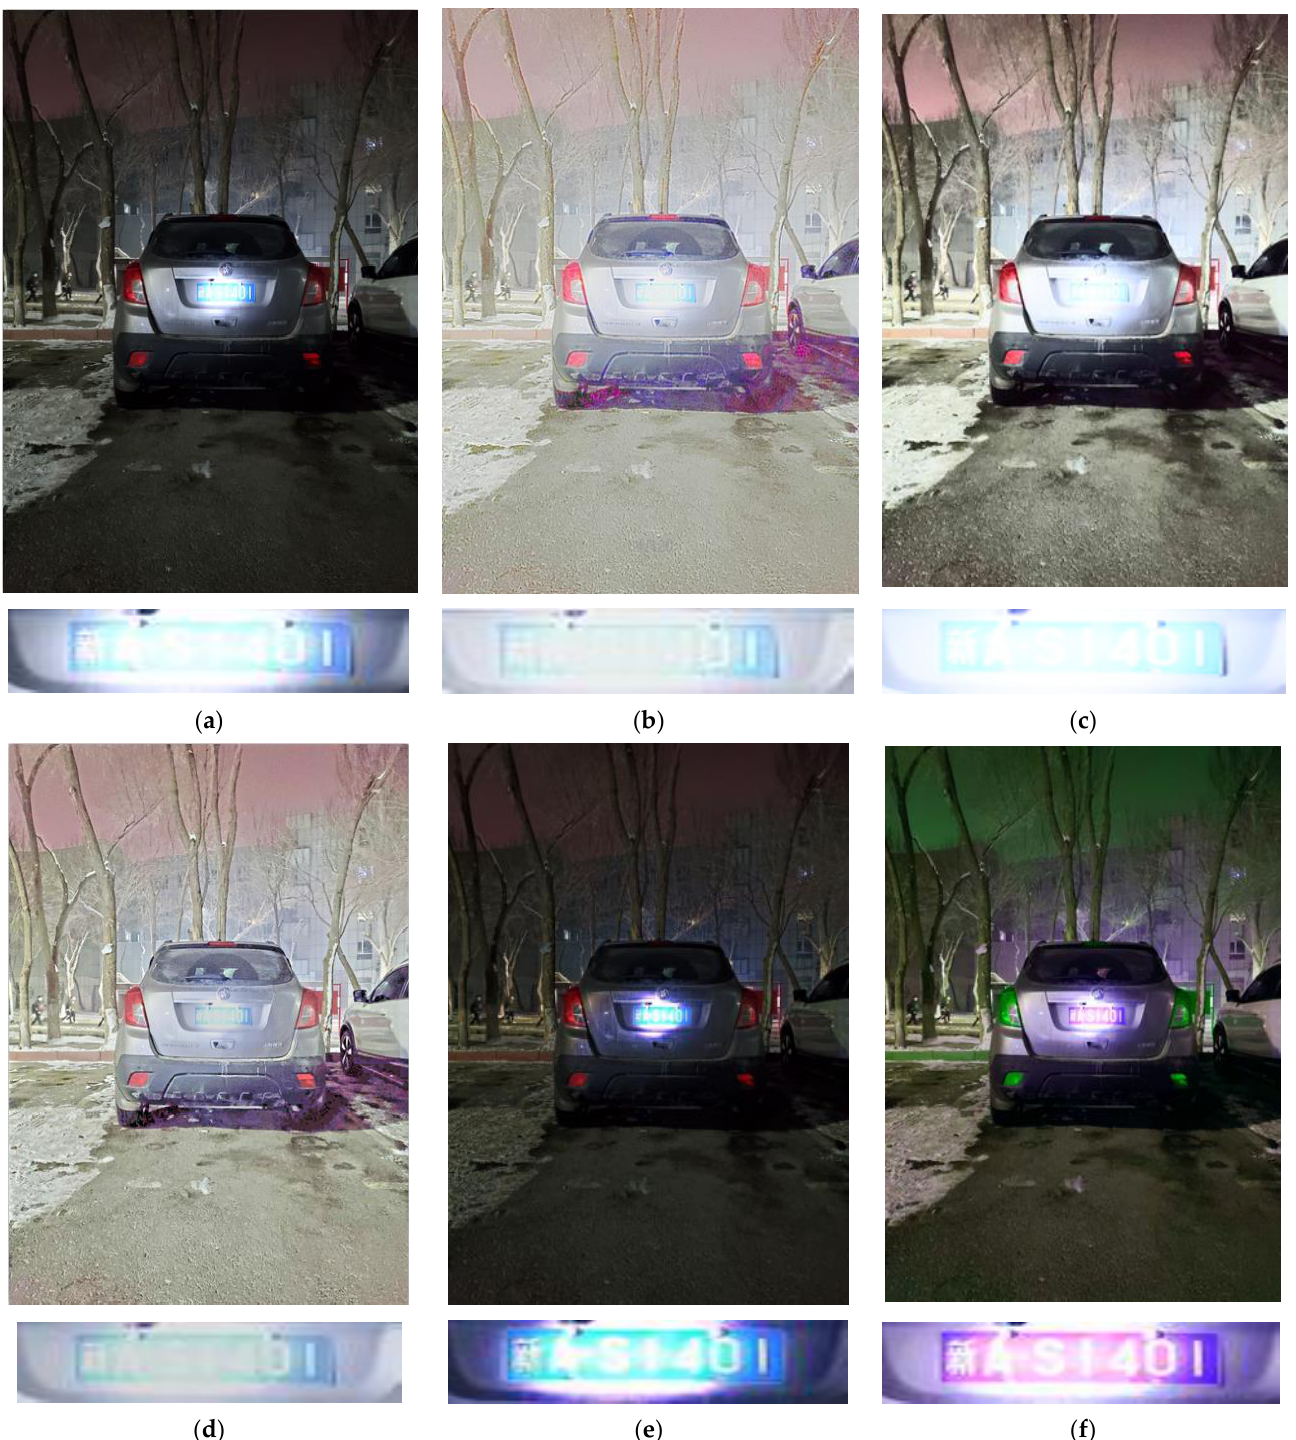
Figure 7. Experimental results: ( a ) original image, ( b ) Hui [35], ( c ) Khan [36], ( d ) Liang [21], ( e ) Xin [37], ( f ) proposed.